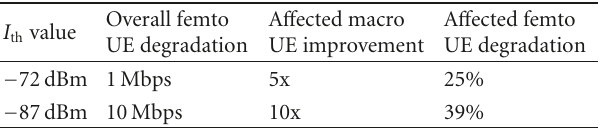
Table 4: Femto UE capacity degradation and macro UE capacity